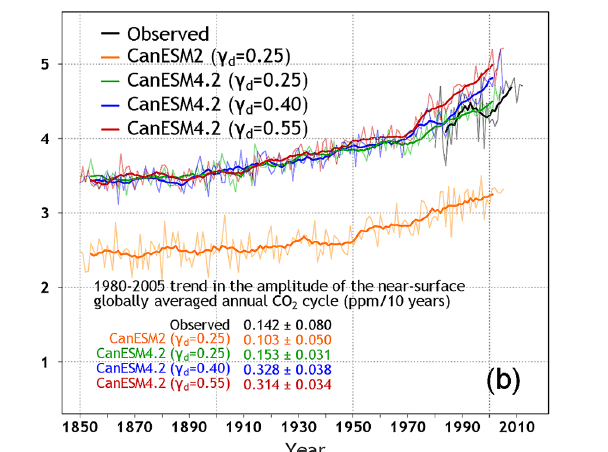
Figure 9. The annual cycle of trend-adjusted globally averaged near-surface monthly [CO 2 ] anomalies from CanESM2, the ver- sions of CanESM4.2 for three different strengths of the CO 2 fer- tilization effect and observation-based estimates for the 1991–2000 period (a) . Panel (b) shows the time series of the amplitude of the annual cycle of the trend-adjusted globally averaged near- surface monthly [CO 2 ] anomalies for corresponding model and observation-based estimates. The bold lines are 10-year moving av- erages and the thin lines for model results are the average of results from two ensemble